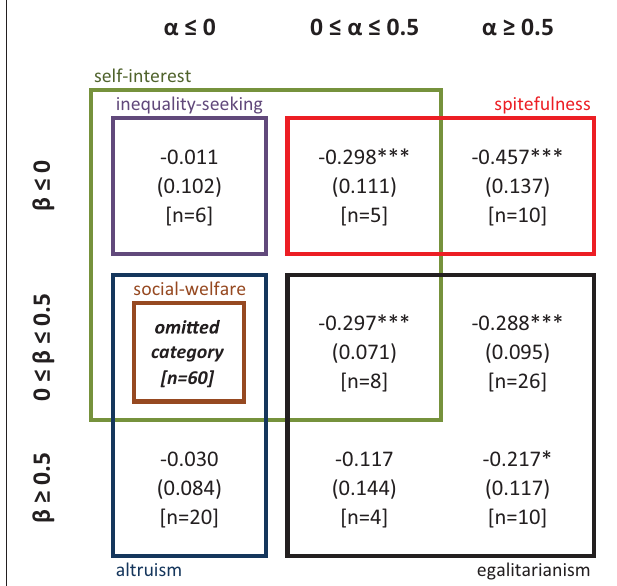
FIGURE 3 | Output of multinomial Probit regression (Study 1). In each cell, the figure shows the coefficient of CRT obtained by comparing that specific social preference category with “ α ≤ 0 , β ǫ [0 , 0.5] ”. * , ** , *** denote p-values lower than 0.10, 0.05, and 0.01, respectively. Ll = − 247.017 , Wald χ 2 = 45.12 ( p < 0.01 ), N = 149 . Robust standard errors clustered on individuals are shown in parentheses, and the number of observations in square